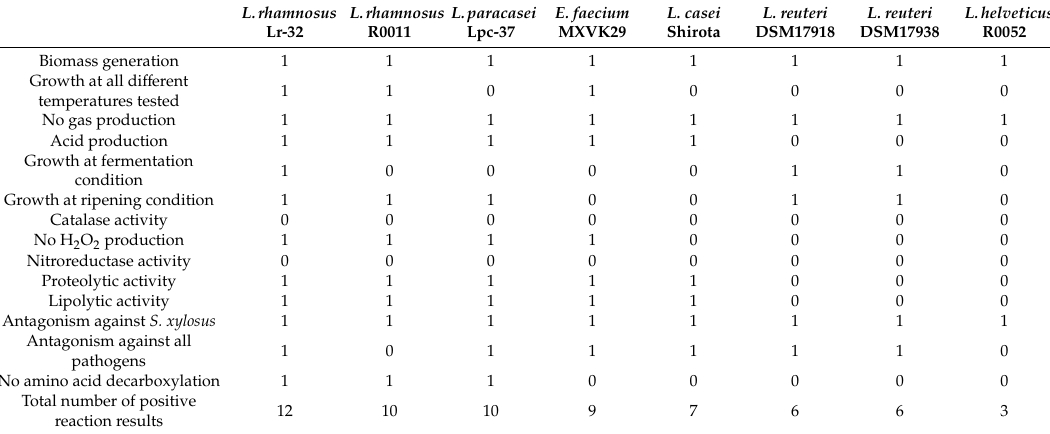
Table 5. Strain selection criteria according to results obtained.